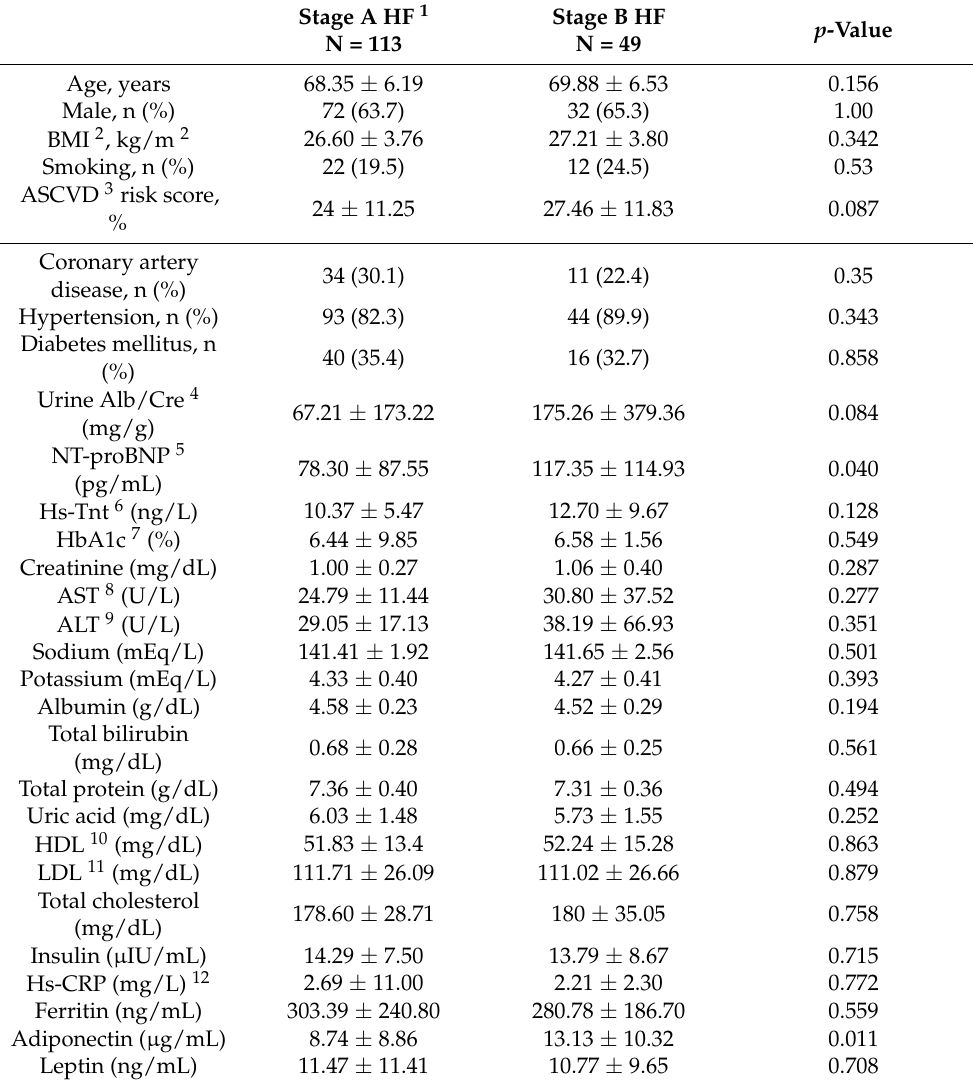
Table 1. Baseline characteristics of both